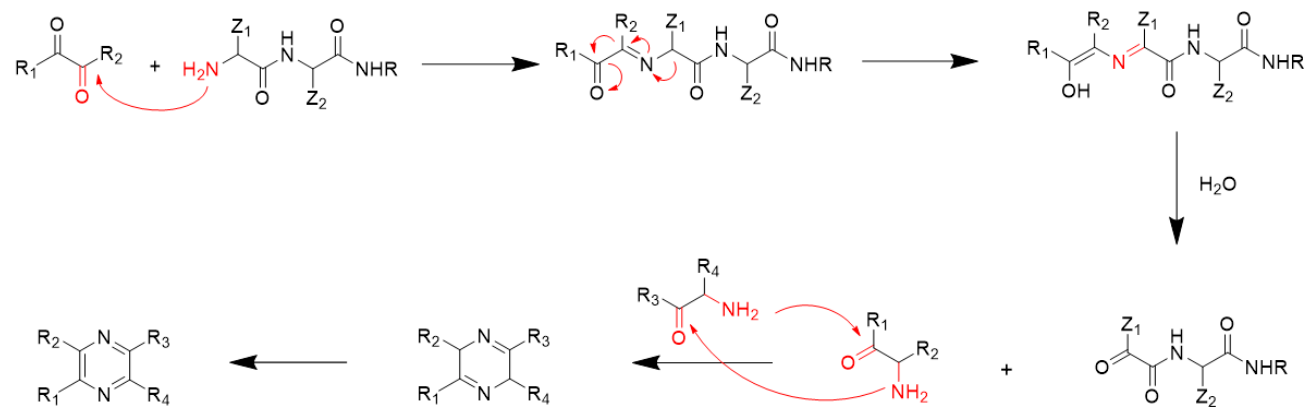
Figure 2. Possible formation mechanism of pyrazines by the reaction of peptides and α -dicarbonyl compounds [29].